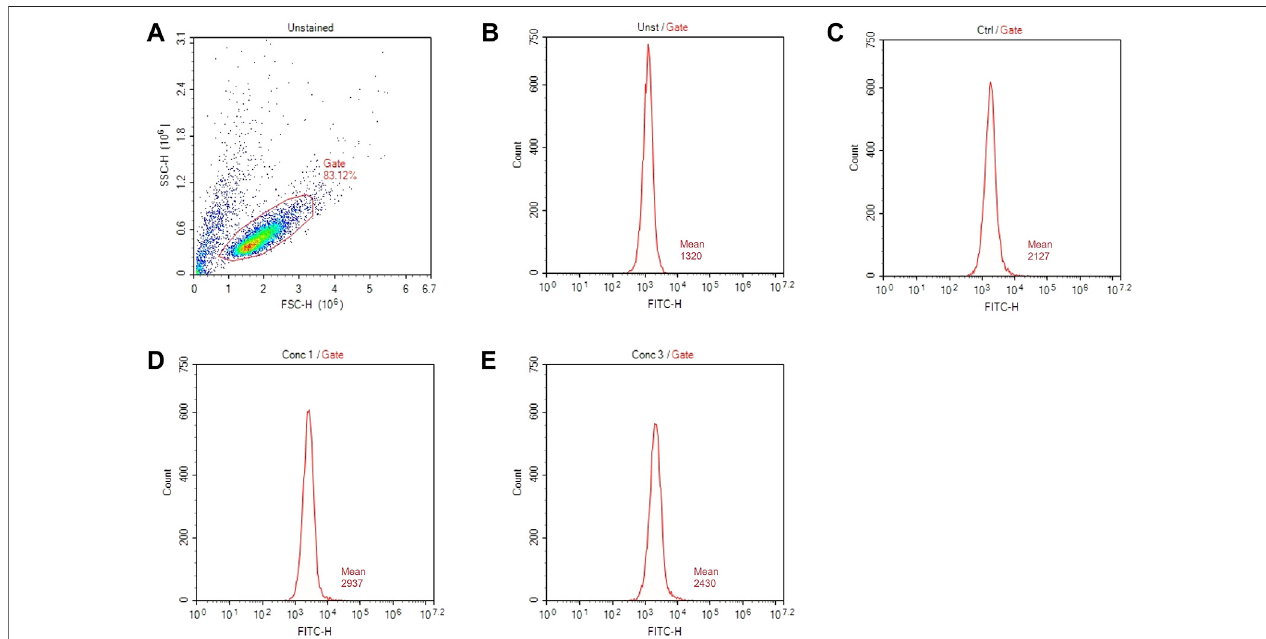
FIGURE3| Gatingstrategiesformarkerassessment. (A) Representativedotplotdiagramofforward-scatter(FSC)andside-scatter(SSC)light.Thethresholdlevel for FSC-H was set to exclude signals from cellular debris. (B) Representative histogram of marker expression of non-treated and non-stained cells (Unst). (C) Representative histogram of the marker expression of control cells (D) Representative histogram of cells treated with a higher non-cytotoxic concentration of drugs (Conc 1). (E) Representative histogram of cells treated with a middle non-cytotoxic concentration of drugs (Conc 3).